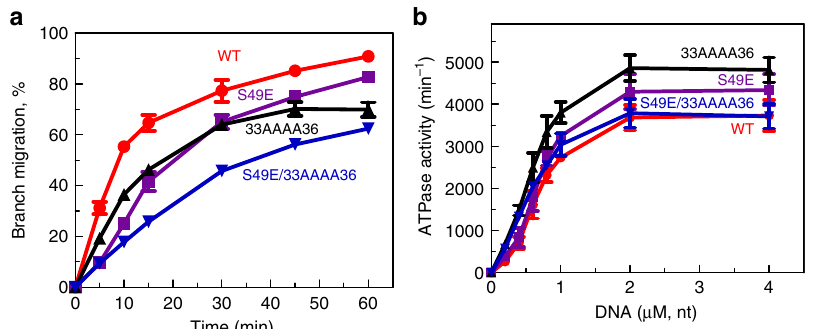
Fig. 5 The S49E and 33AAAA36 mutations inhibit BM, but not ATP hydrolysis. a The effect of the S49E and 33AAAA36 single and double mutations on the kinetics of BM of PX junction (no. 71/169/170/171; 32 nM) by RAD54 (60 nM). b The effect of the S49E and 33AAAA36 mutations on ATP hydrolysis by RAD54 (20 nM) using supercoiled pUC19 as DNA substrate. Each experiment was repeated three times. Error bars represent